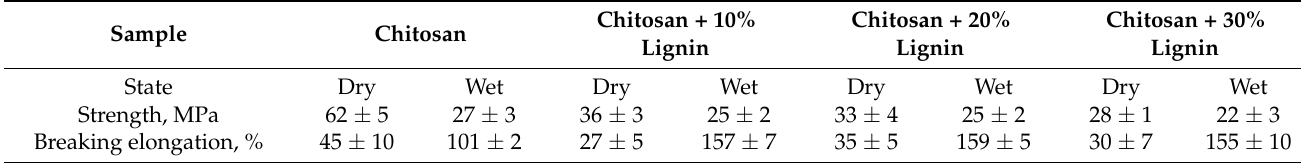
Table 2. Mechanical characteristics of chitosan films and their composites; sample base length: 10 mm.